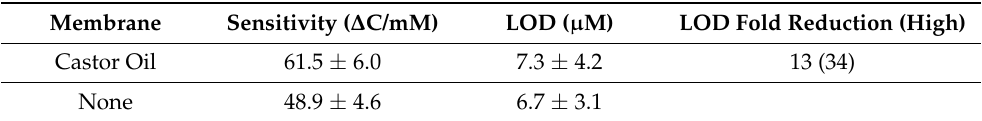
Table 4. Summary of the analytical performance of boron-doped diamond with and without inte- grated oil–membrane protection in human serum for hexaammineruthenium (II/III)